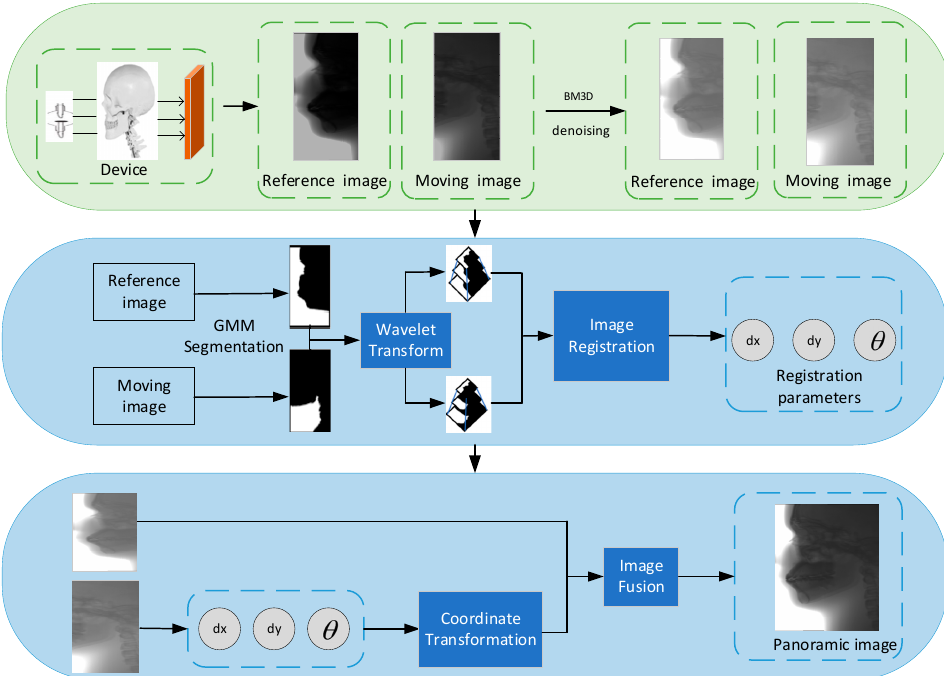
Figure 3. Flowchart of the proposed method for lateral cranial image stitching.